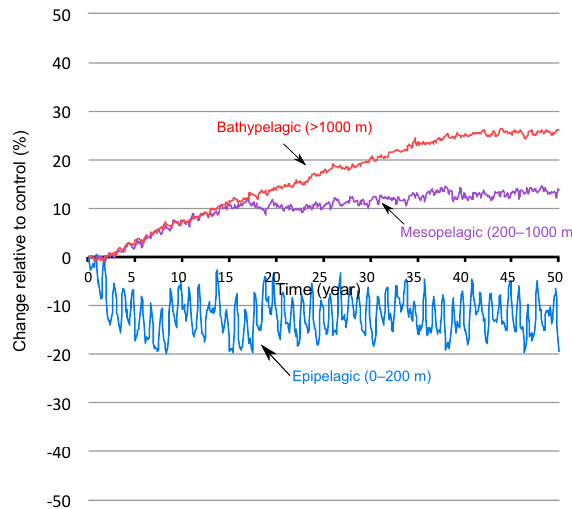
Figure 8. OMZ response in different vertical layers as a function of time. Changes in hypoxic volume (in %) under wind stress increase ( + 50%) in the epipelagic zone (0–200m), the mesopelagic zone (200–1000m) and the bathypelagic zone ( >